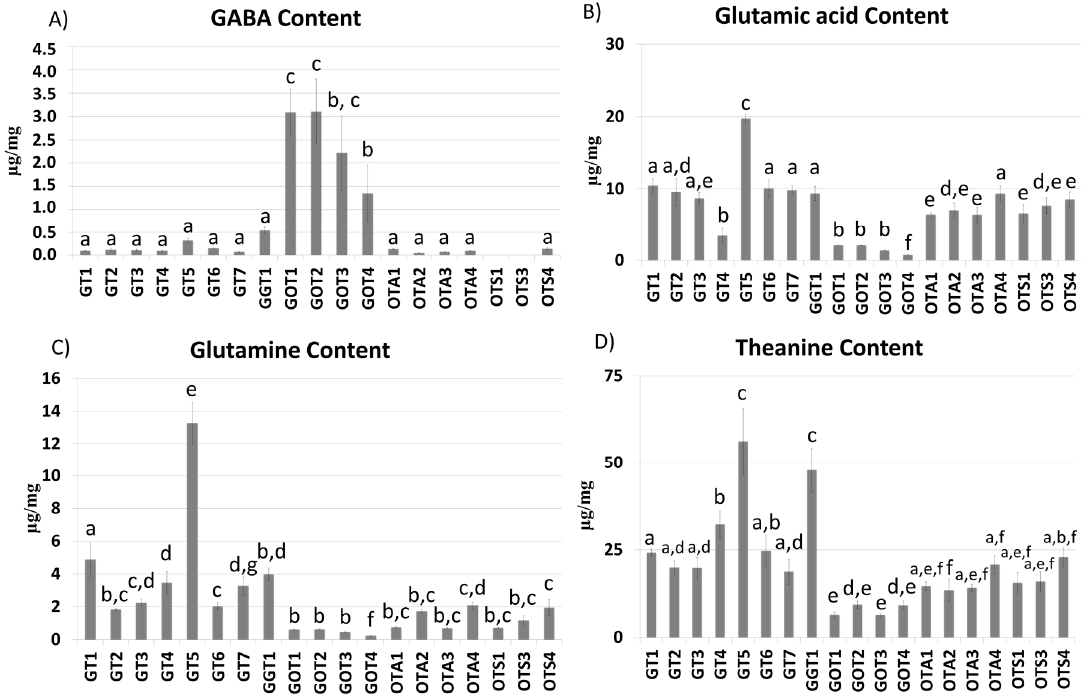
Figure 6. GABA ( A ), glutamic acid ( B ), glutamine ( C ), and theanine ( D ) concentrations ( µ g/mg of tea dried residue) in the 19 analyzed teas. Data are expressed as mean of three independent measurements ± SD; different letters indicate statistically significant differences ( p < 0.05) between two groups.